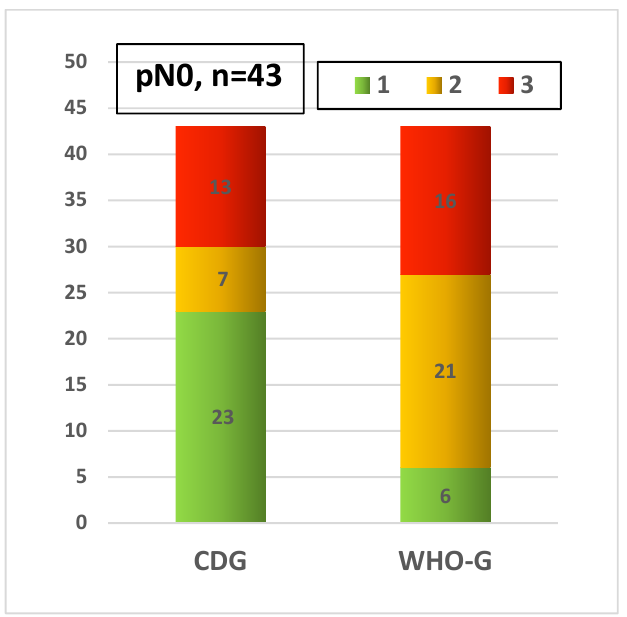
Figure 8. Distribution of both grading systems with pN0 cases.